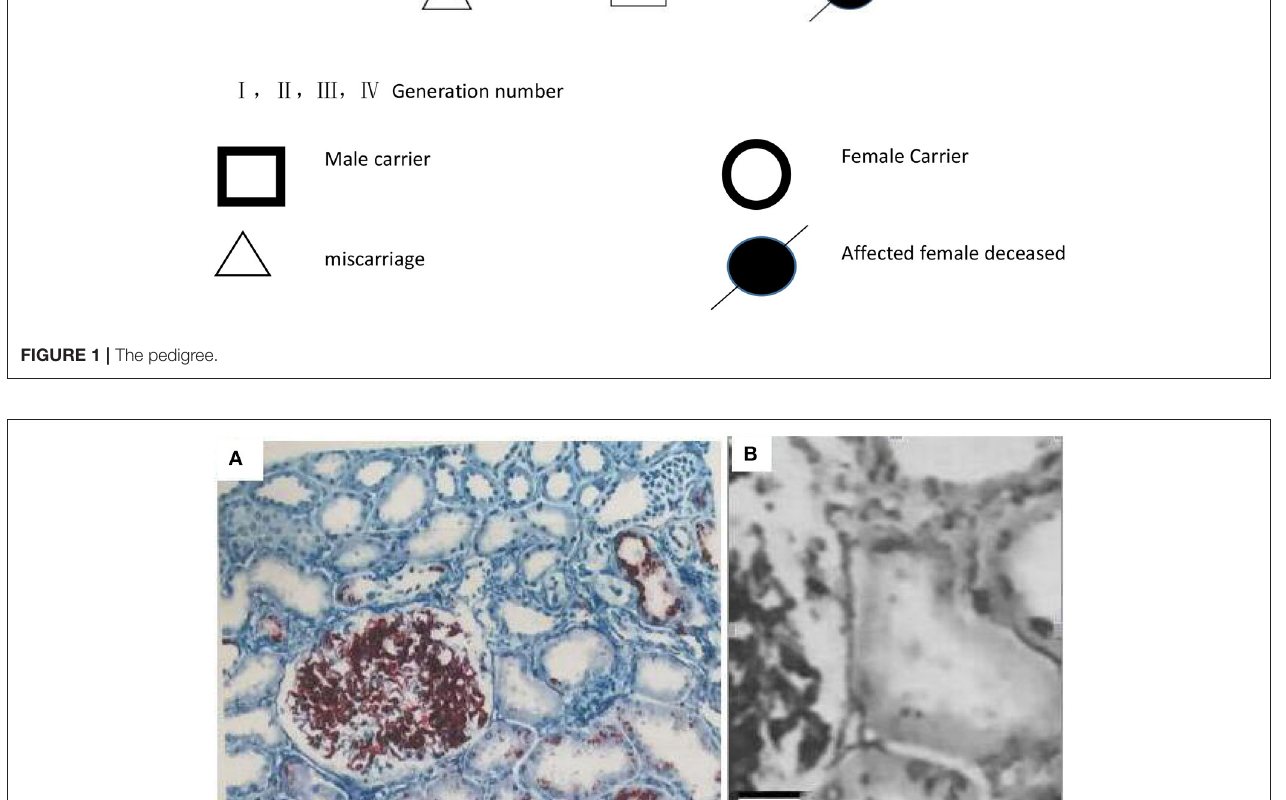
reported morphological findings in a patient with a milder variant of Pierson syndrome. A Light microscopic appearance of glomeruli showed no abnormalities (8). Rene et al. described a newborn infant who was presented with congenital